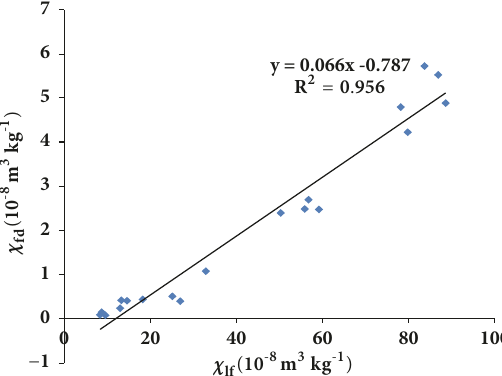
Figure 4: Interdependence between 𝜒 fd and 𝜒 lf for cultivated land.